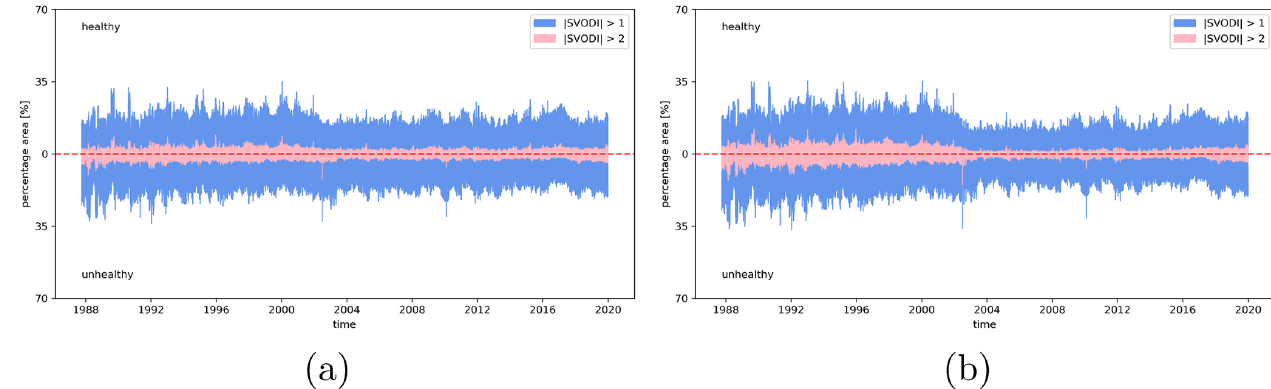
Figure 4. Fraction of pixels that are extreme of SVODI (a) and non-probabilistic merge of indices (b) over time.